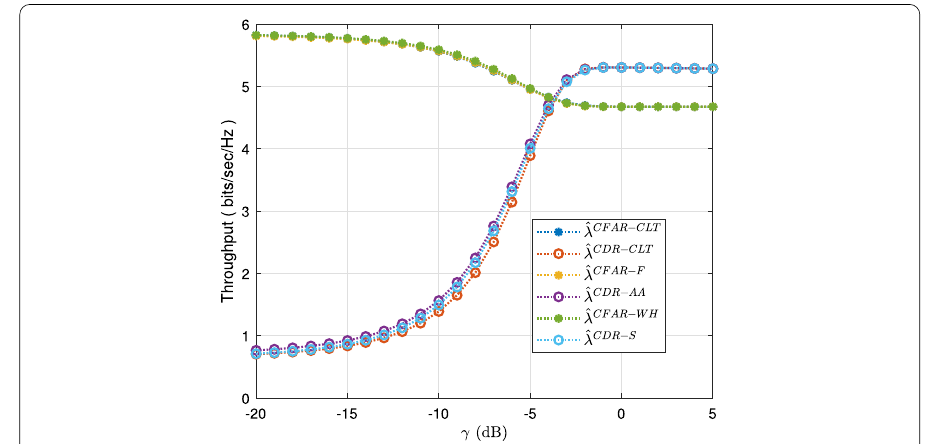
Fig. 8 Throughput for SU link as function of γ for a constant number of samples N